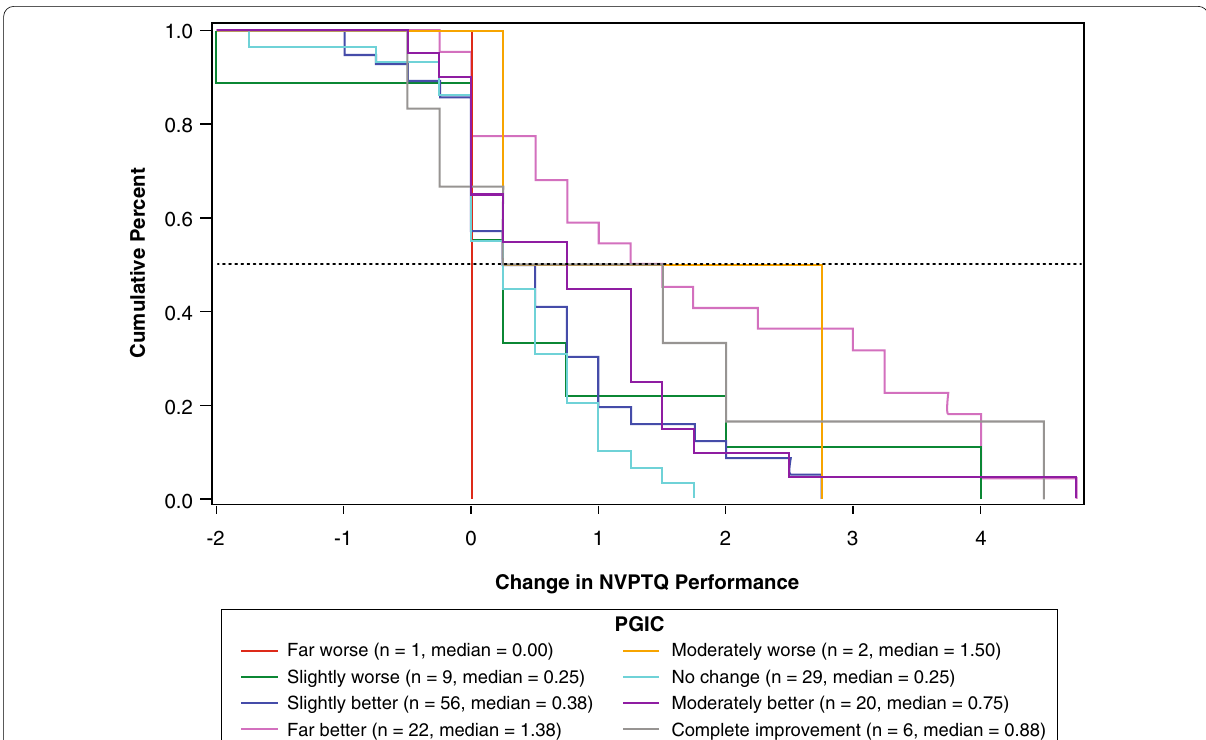
Fig. 6 eCDF of change in NVPTQ Performance by PGIC. Note Change is computed as Day 28 Hour 1 minus Day 1 Hour 0. Positive scores indicate improvement. eCDF, empirical cumulative distribution; NVPTQ, Near Vision Presbyopia Task-based Questionnaire; PGIC, Patient Global Impression of